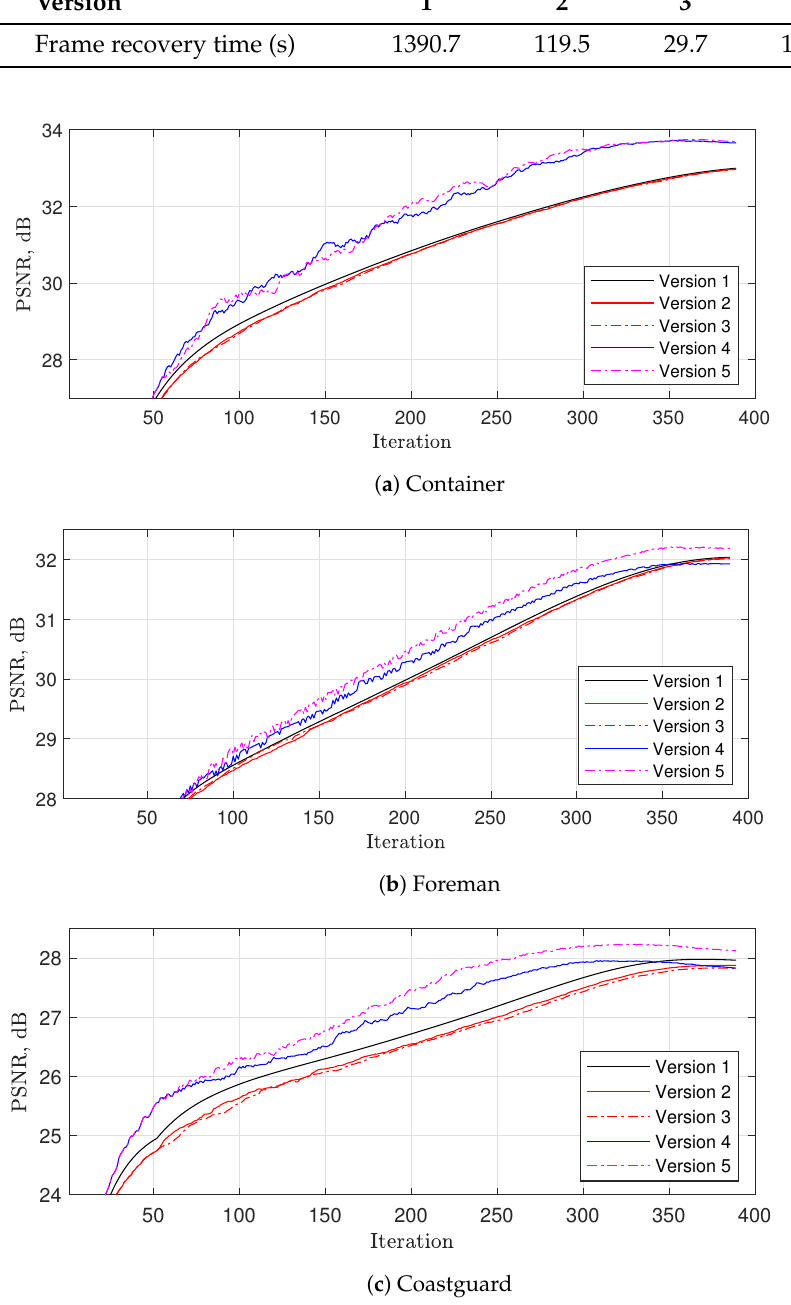
Figure 4. Comparison of different versions of thresholding with 16 × 16 × 16 DCT for R = 5%. Here, Version 1 is the thresholdig according to Algorithm 2, Version 2 is Version 1 with random selection of shifts ( s i , s j ) from set { 0, N /2 } , Version 3 is Version 2 , in which hierarchical motion estimation